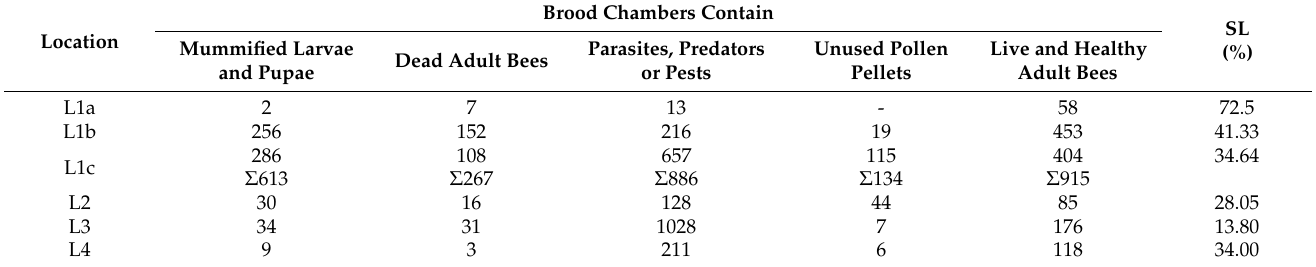
Table 3. Summarized data of survival level and health status of solitary bees for different sampling location and management practices, based on number of healthy bees in comparison with determined individual rearing